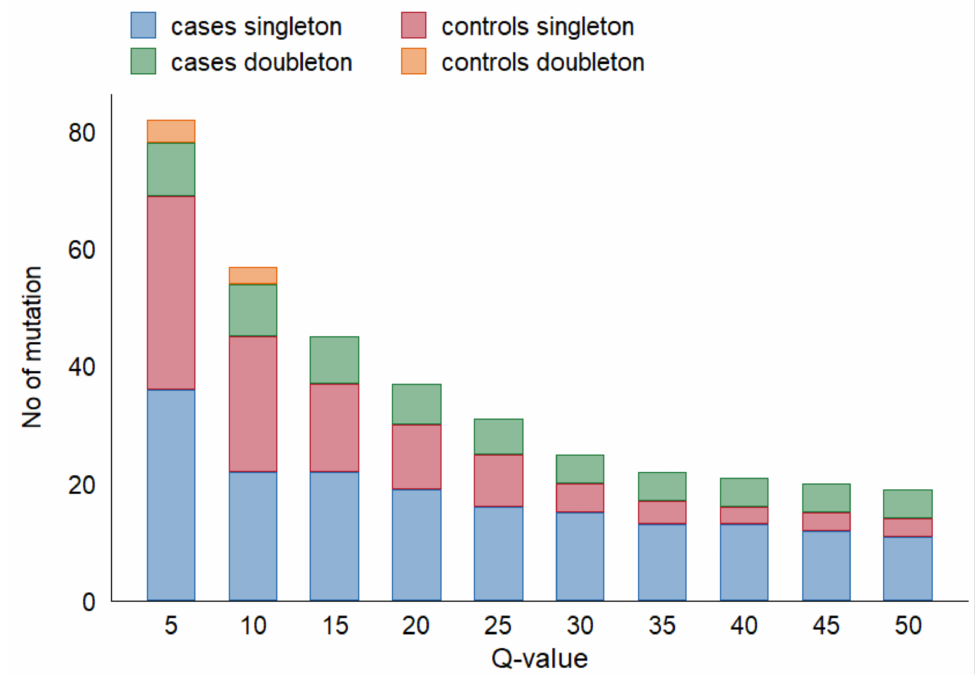
Figure 2. Effect of Q-value threshold on detecting TP53 variants in